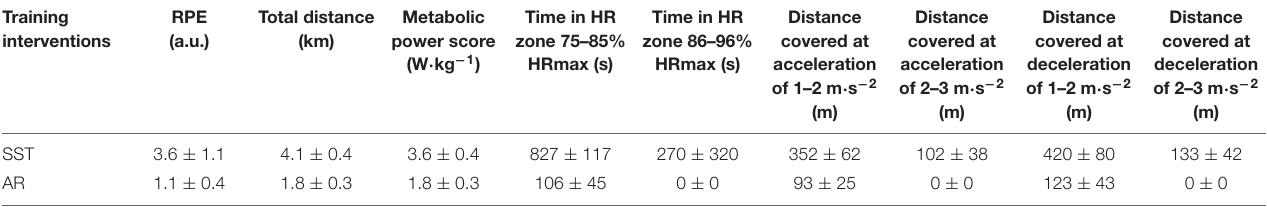
TABLE 1 | Perceived load assessed by CR10 Borg scale; kinematic, metabolic, cardiovascular, and mechanical load parameters assessed by GPS for both interventions. Training RPE interventions (a.u.)